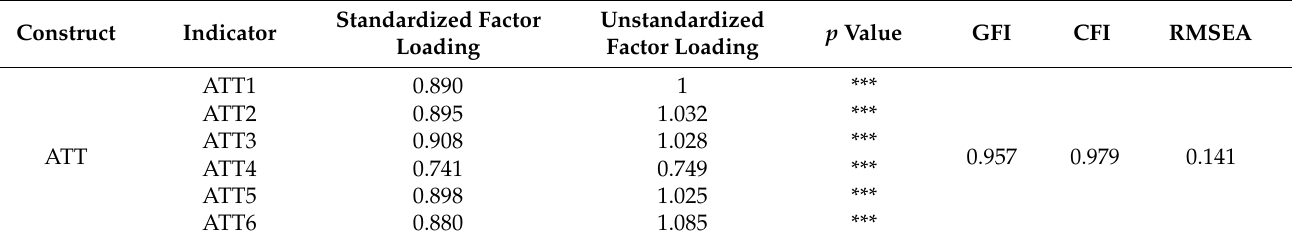
Table 3. CFA of attitude towards